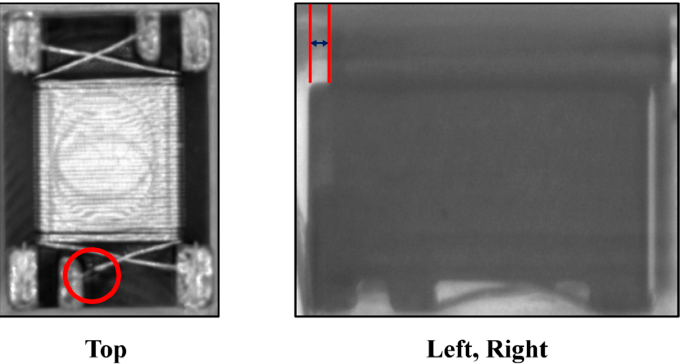
Figure 10. Defective coil image data.